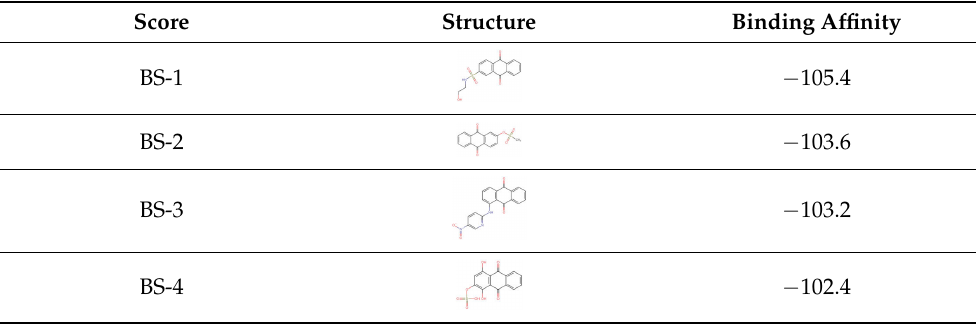
performed with PLANTS-1.2 software. Scores in PLANTS are